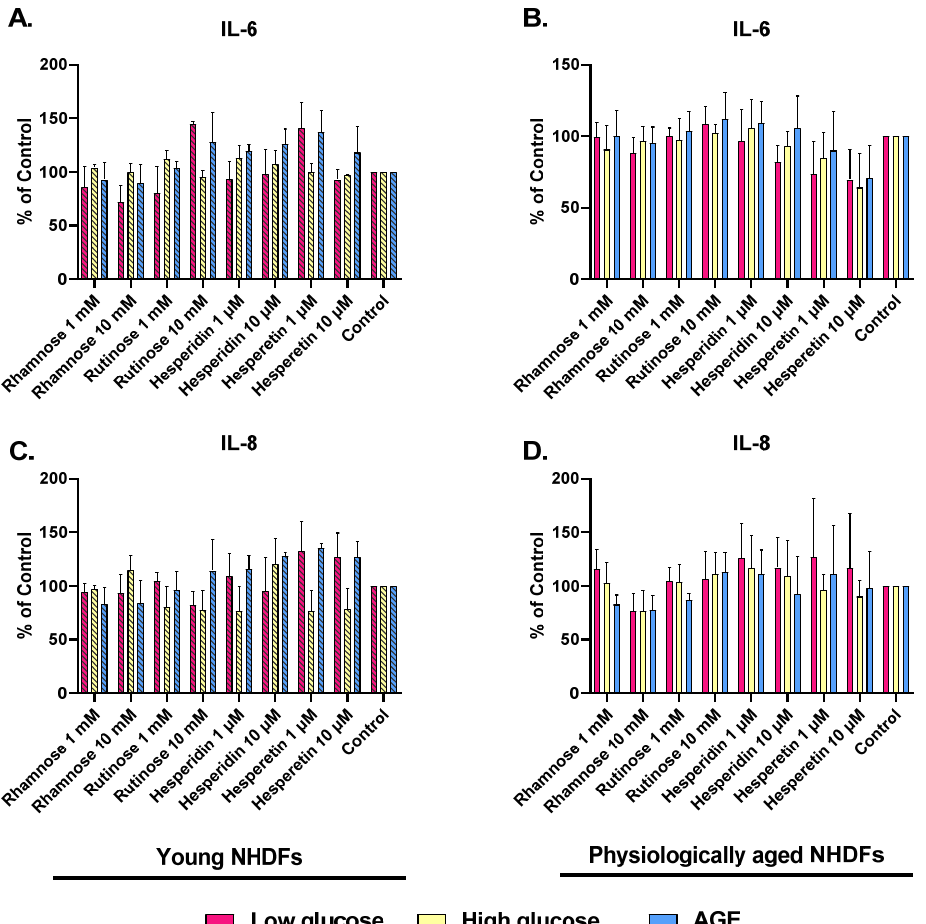
Figure 5. The effects of rhamnose, rutinose, hesperidin, and hesperetin on IL-6 ( A , B ) and IL-8 ( C , D ) production by young or physiologically aged NHDFs, that were cultivated in low-glucose medium, high-glucose medium, and medium supplemented with AGEs. Untreated NHDFs cultivated in these individual media were used as controls. A number of measurements: n = 6. (One-way ANOVA; Dunnett’s multiple comparisons tests were performed using GraphPad Prism).